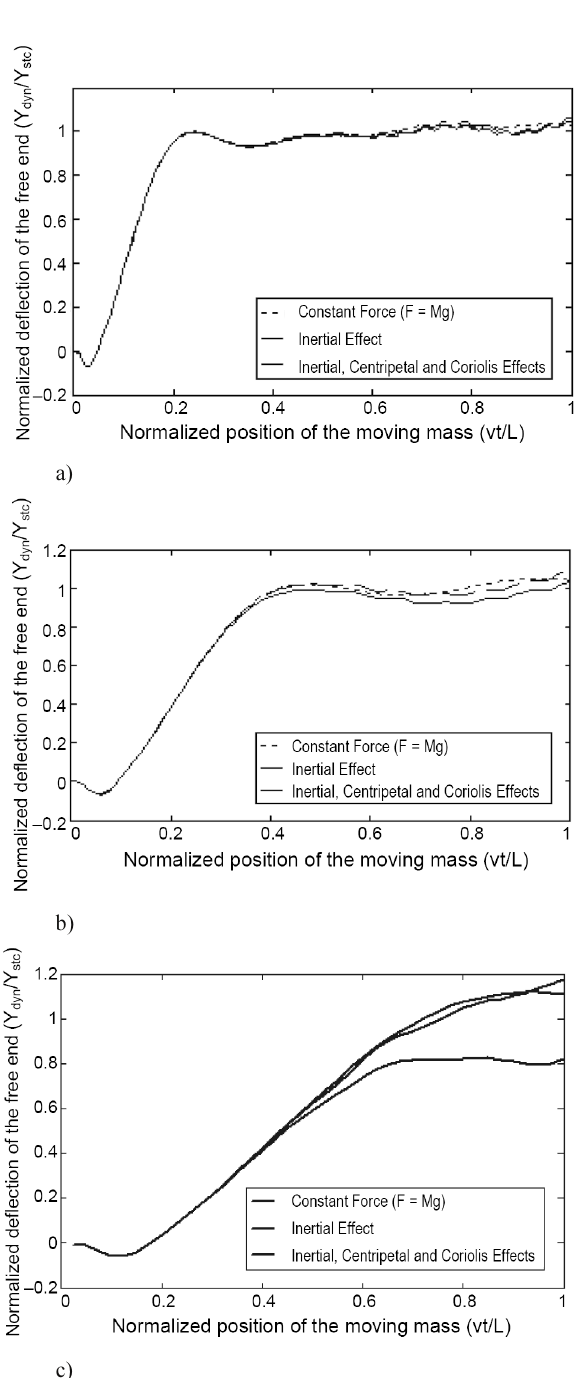
Fig. 4. Variation of the normalized deflection at the free end with respect to normalized position of moving mass for differ- ent values of the velocity of the moving load. L 0 = 4 m, γ = 0.5, M = 1000 kg: a) v = 5 m/s; b) v = 10 m/s; c) v = 20